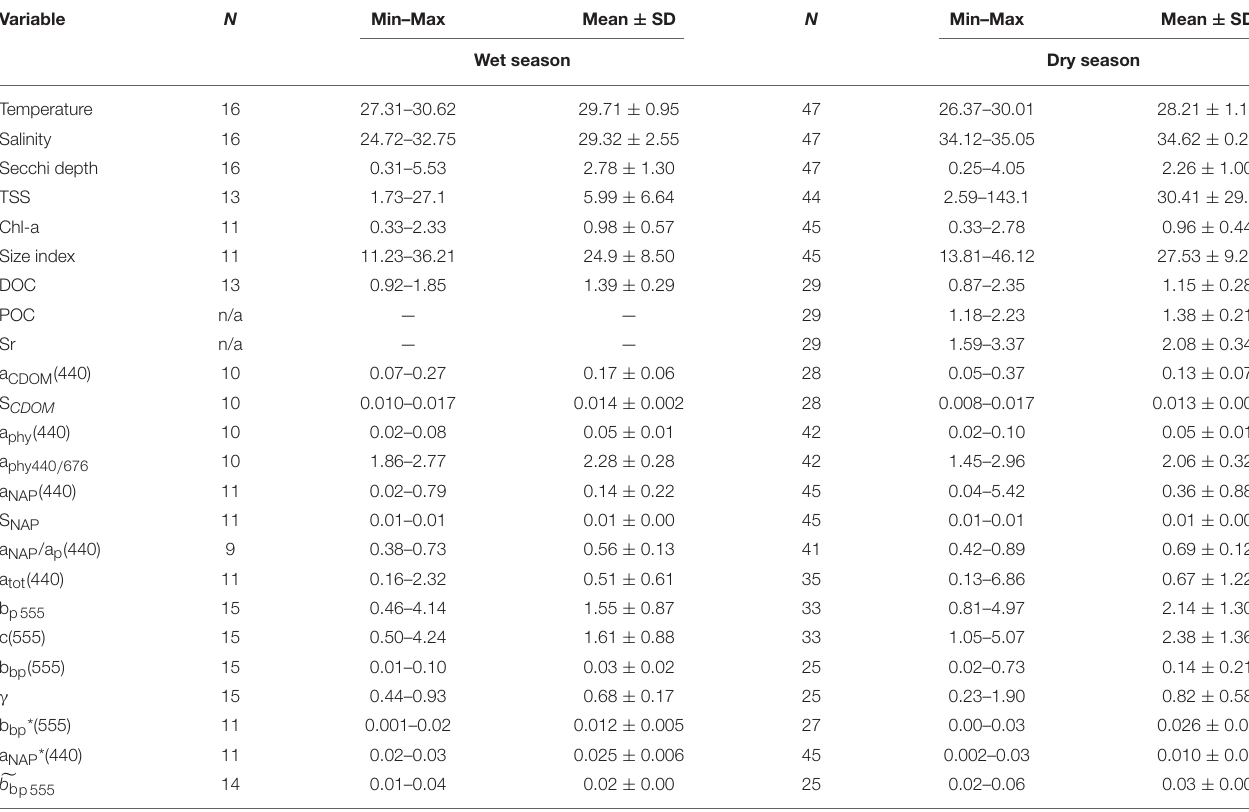
TABLE 2 | Range of surface ( < 2 m) values in metadata, concentrations and IOPs in the Van Diemen Gulf and Darwin Harbour during the 2012–2013 dry and wet seasons field samplings.